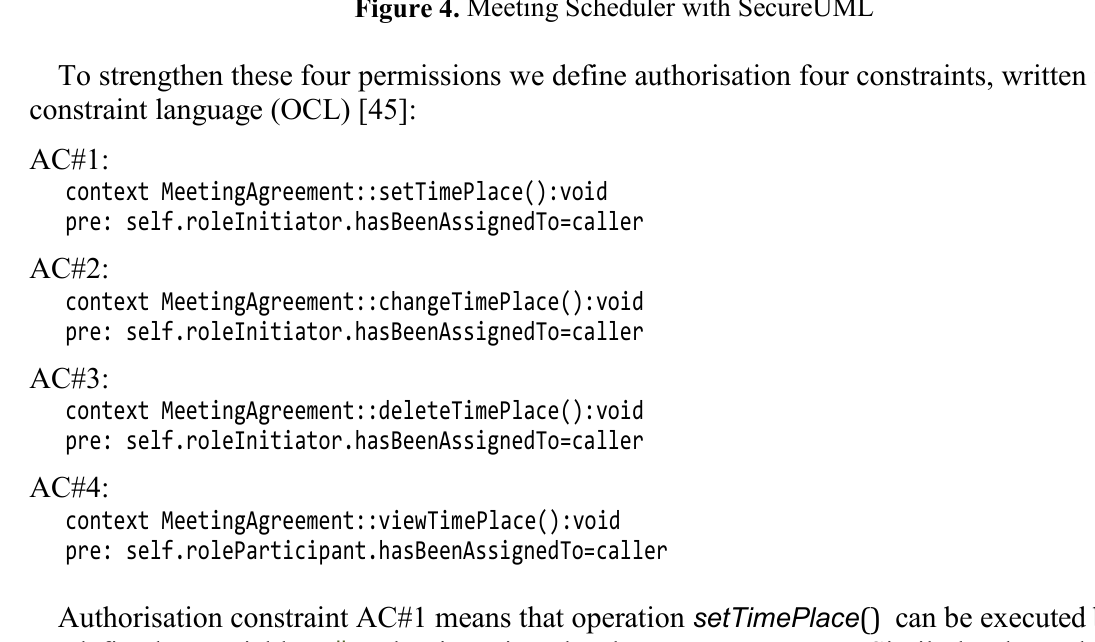
Figure 4. Meeting Scheduler with